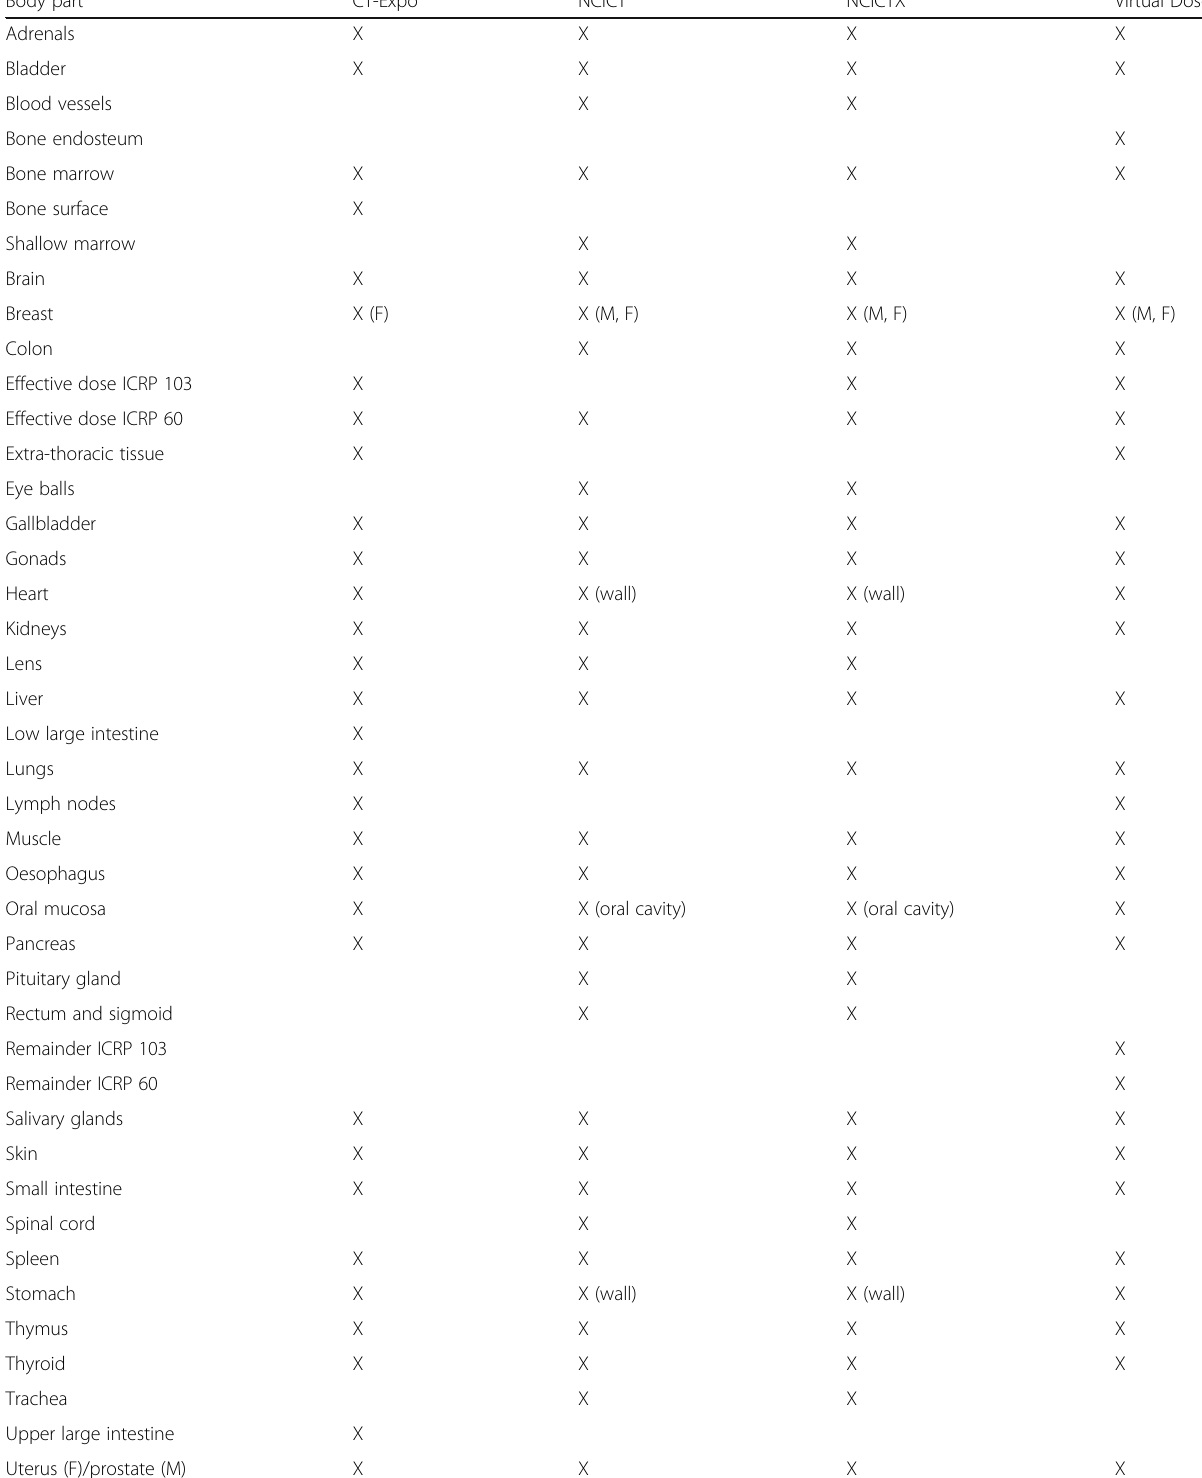
Table 2 List of the body parts considered by CT-Expo, NCICT, NCICTX, and Virtual Dose for organ dose estimation Body part CT-Expo